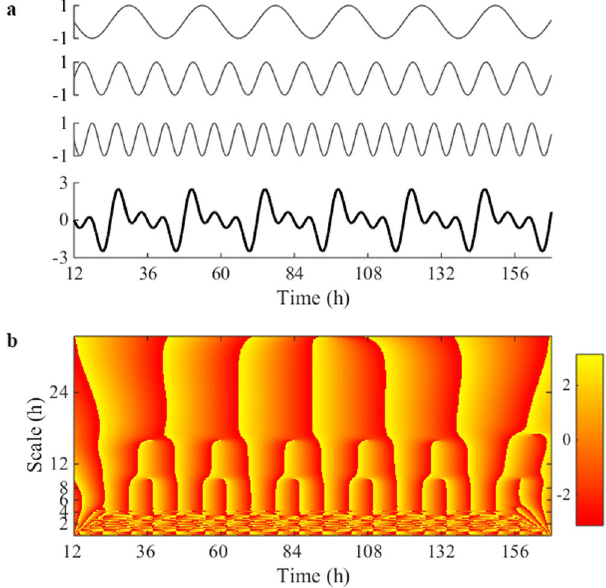
Figure 5. Example of wavelet analysis of ultradian rhythms using a synthetic time series. ( a ) Example time series constructed as the sum of three sine waves of the same amplitude but different periods corresponding to 24 h, 12 h and 8 h (from top to bottom panel), considering a duration of 6.5 days and a 0.5 s sampling rate. ( b ) Amplitude plots of phase angle of the wavelet Morlet transform. The x -axis represents time (6.5 days) and the y -axis indicates the scale of the wavelet used (from 6 min to 26 h). Notice the similarities with Fig. 4 in the branching pattern for time scales ≥ 8